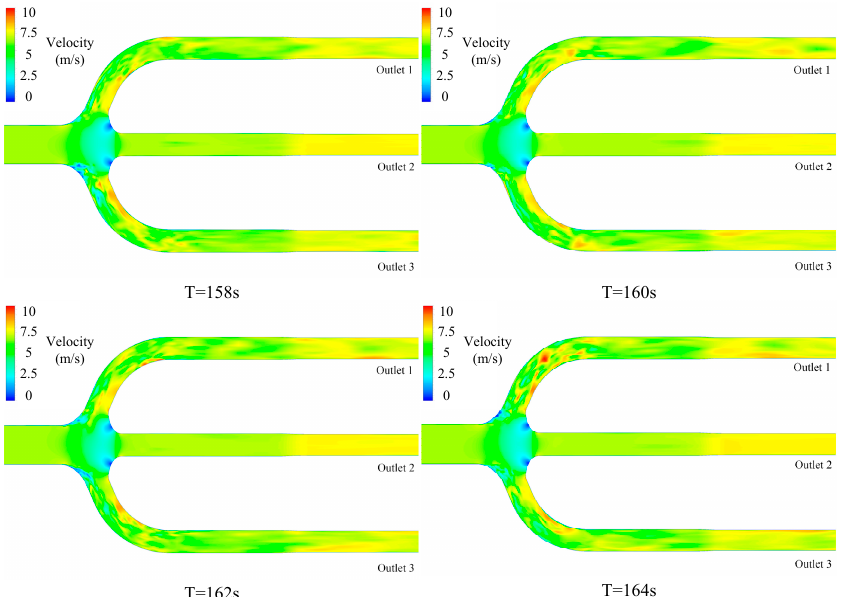
ff erent times (original